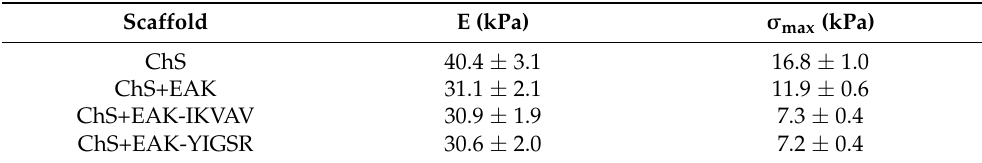
Table 1. Mechanical properties of ChS, ChS+EAK, ChS+EAK-IKVAV, and ChS+EAK-YIGSR scaffolds: compressive modulus € and maximum stress ( σ max ) reported as mean value ± standard